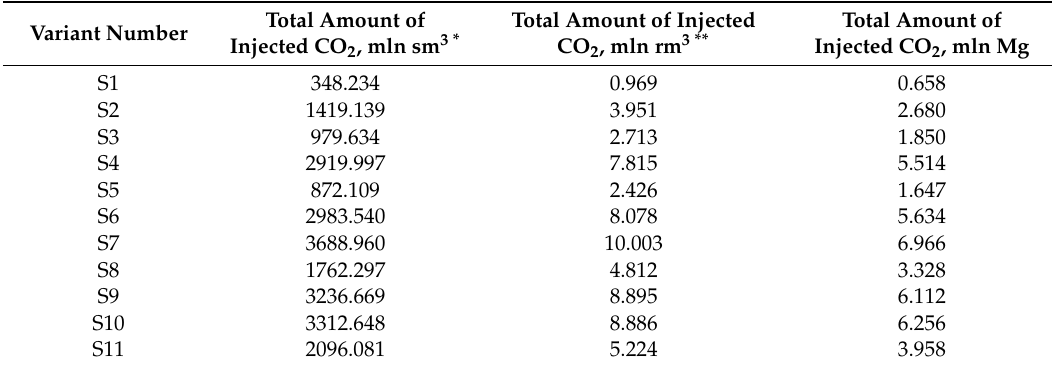
Table 7. List of the results obtained for the total amount of CO 2 injected in individual variants of simulation in the Cracow Sandstone Series model.